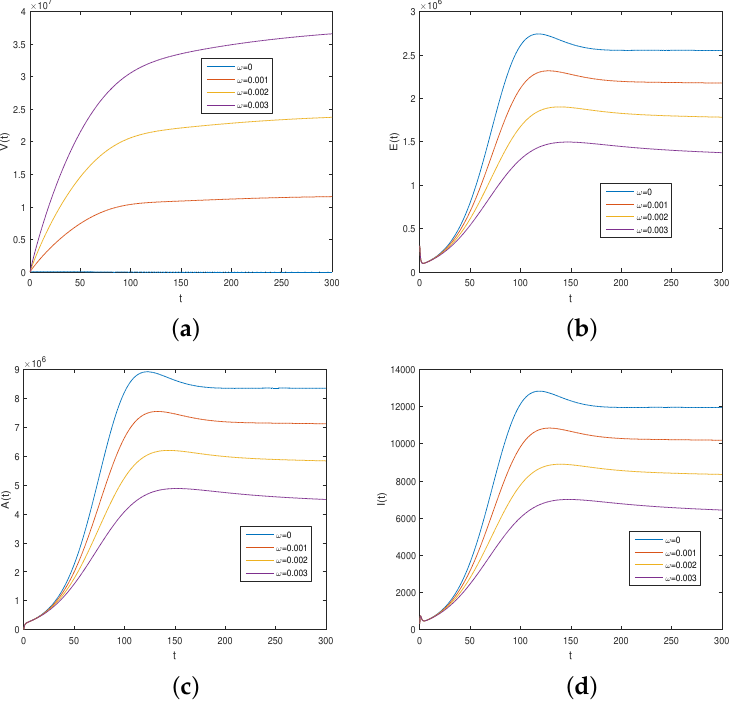
Figure 5. Impact of the vaccination rate on the components of the system for different values of ω and less efficacy, ψ = 0.6 and η = 0.95. Subfigures ( a – d ) describe the dynamics of vaccinated, exposed, asymptomatic, and symptomatic individuals